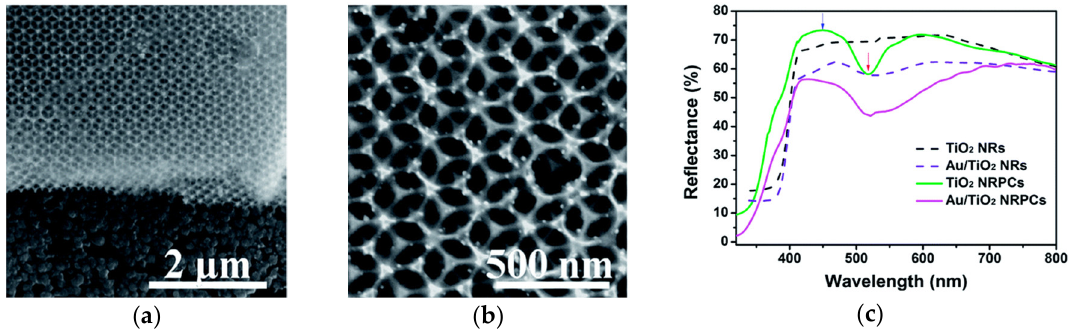
Figure 5. ( a ) Low-magnification and ( b ) high-resolution scanning electron microscopy images of Au/TiO 2 PCs on the fluorine-doped tin oxide (FTO) substrate, ( c ) Diffused reflectance spectra of TiO 2 nanorods (NRs), Au/TiO 2 NRs, TiO 2 NRPCs, Au/TiO 2 NRPCs (PBG marked with dark arrow and slow-photon region marked with red arrow); Reprinted with permission (after formatting) from [118]. Copyright (2014) RSC.